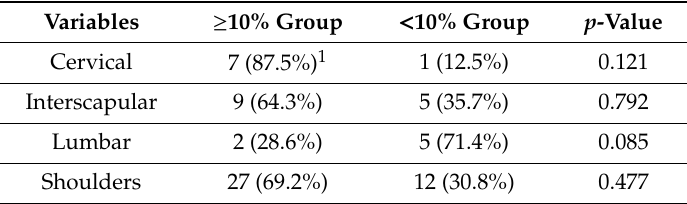
Table 3. Areas of